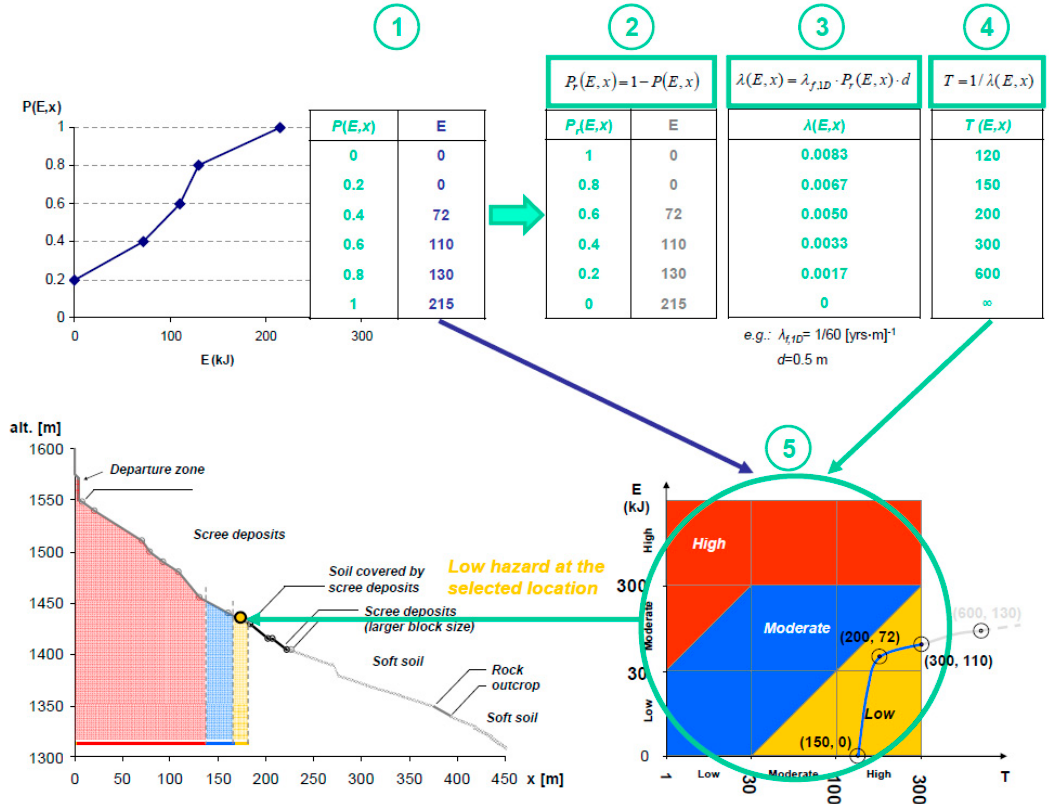
Figure 1. Steps of the new Cadanav methodology for one-dimensional zoning, after a failure frequency per unit length has been defined and trajectory simulations run. (1) Cumulative energy-probability distribution E - P ( E , x ) determined from raw trajectory modelling results—an initial value of 0.2 means that 20% of the blocks stopped before the selected location; (2) computation of probability of reach P r ( E , x ), (3) frequency of occurrence λ ( E , x ) and (4) return period T ( E , x ) corresponding to each energy value E ; (5) superimposition of the E-T couples to an intensity frequency diagram for hazard qualification.